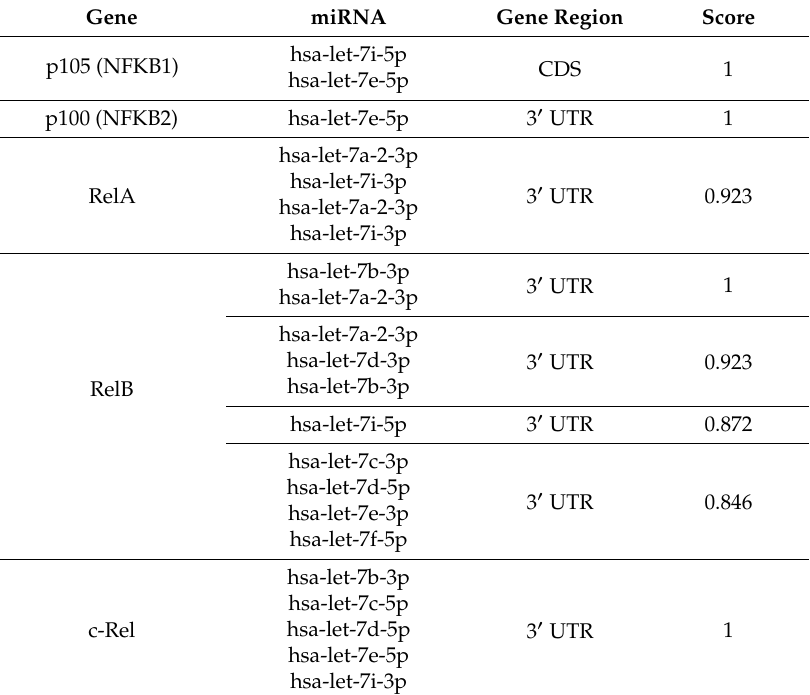
Table 1. Predicted let-7 targets among the NF- κ B subunits